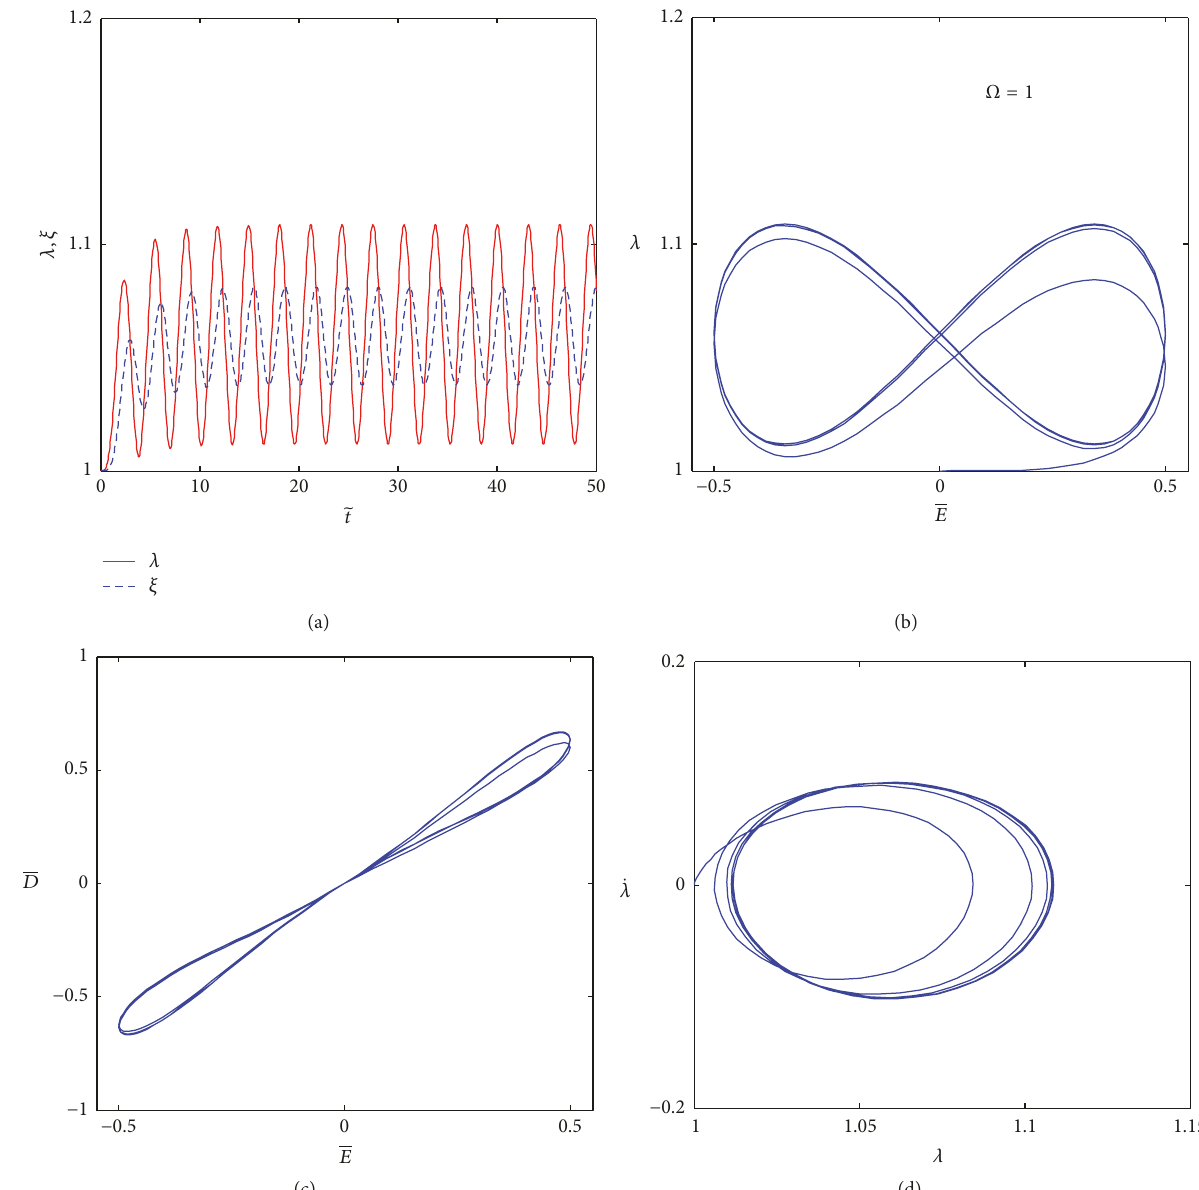
Figure 5: The total stretch 𝜆 , the viscous stretch 𝜉 (a), the nominal electric field-stretch response (b), the nominal electric field-nominal electric displacement (c), and the phase diagram (d) for the dimensionless frequency Ω = 1